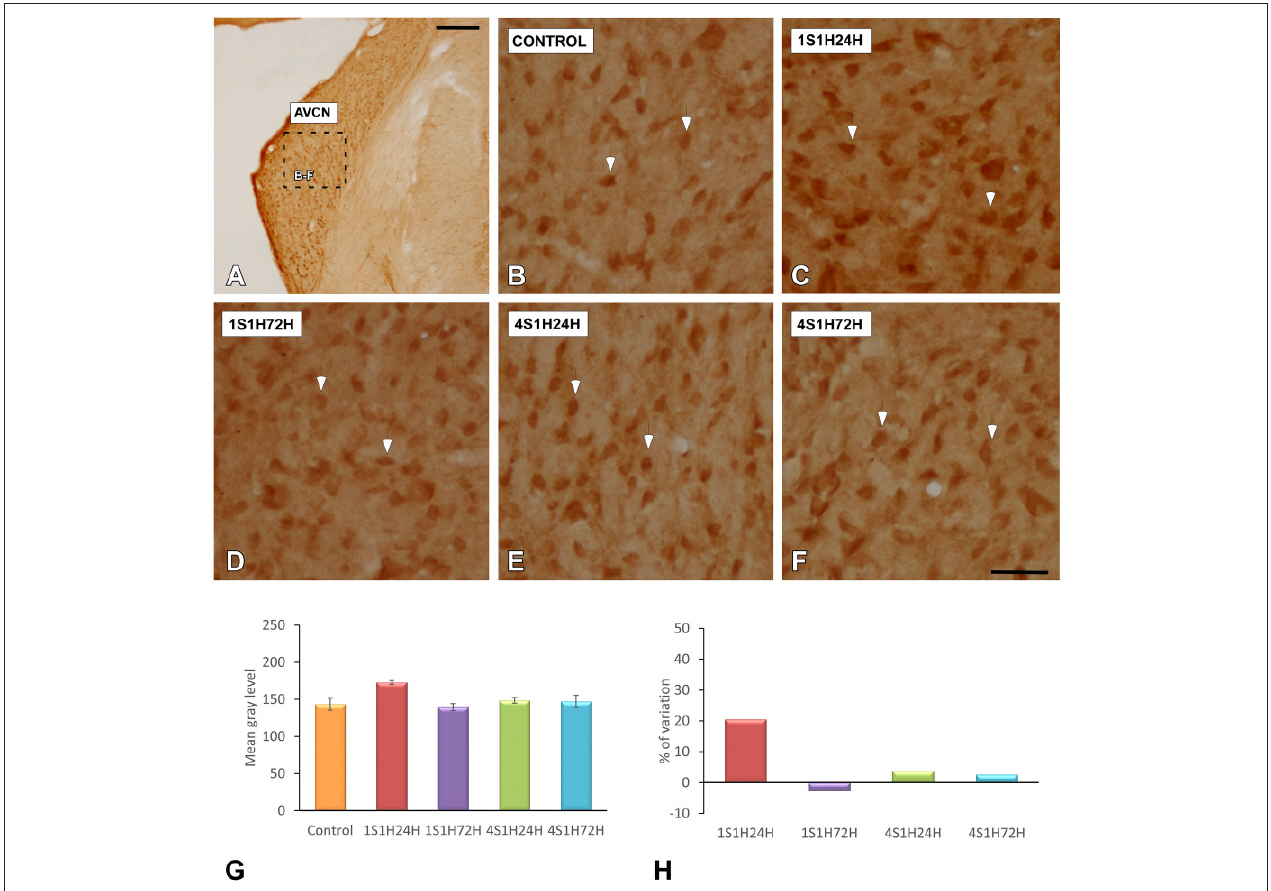
FIGURE 10 | Digitized images illustrating nNOS immunostaining in the AVCN in control and experimental Wistar rats. nNOS-immunostaining was increased by 24h after the first session (arrows in C ), and diminished in 1S1H72H (arrows in D ), 4S1H24H (arrows in E ), and 4S1H72H (arrows in F ) conditions to reach normal values (arrows in B ). Bar graphs indicate the mean gray level of nNOS immunostaining in the AVCN (G) and its percentage of variation (H) in the experimental conditions relative to control. The square box in (A) indicates the approximate location of the high-magnification images shown in (B,C,E,F) . Scale bars represent 250 µ m in (A) , and 50 µ m in (F)